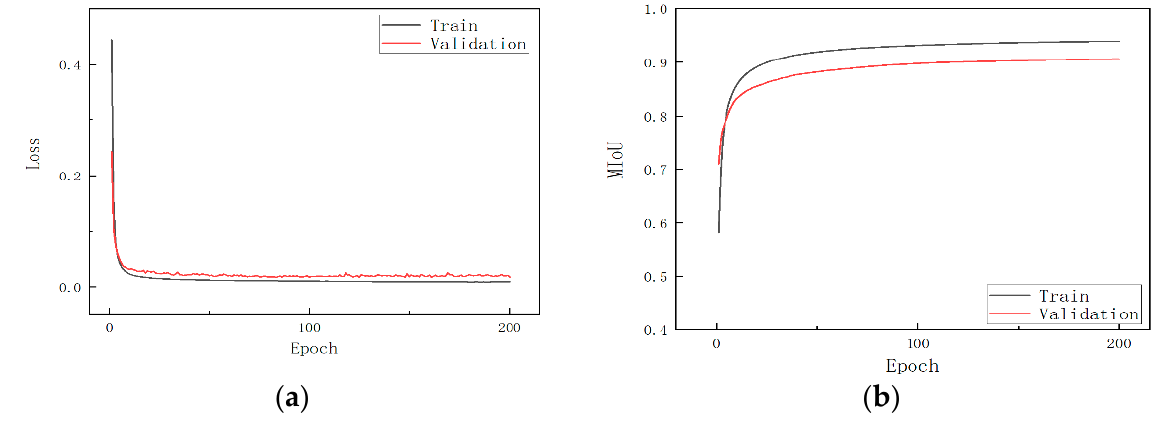
Figure 10. ( a ) Training loss and ( b ) MIoU change.